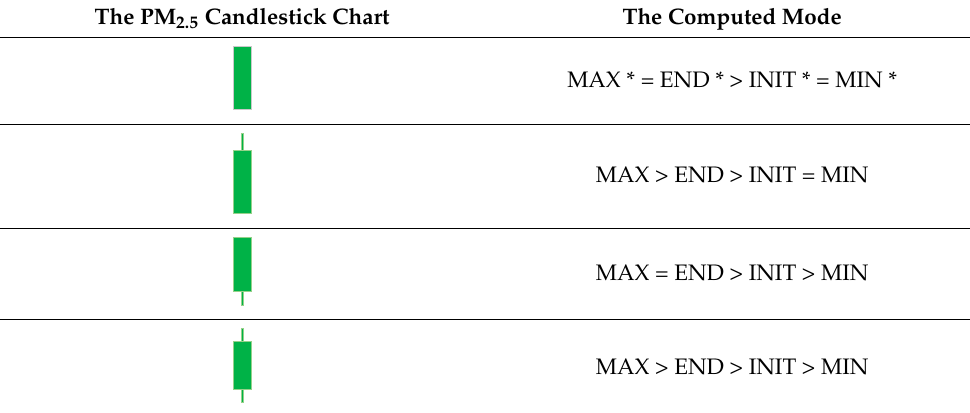
Figure 3. Relationship between the PM 2.5 concentration change at the target point. Assuming that Q is unchanged, the relationship between the change in v and C is shown in ( a ). Assuming that Q is unchanged, the relationship between the change in d and C is shown in ( b ). Assuming that v and d remain unchanged, the relationship between Q and C is shown in ( c ). Table 2. The calculation methods of the nine basic forms of PM 2.5 candlestick chart. Table 1. Nine basic patterns of the candlestick charts. The PM 2.5 Candlestick Chart The Computed Mode